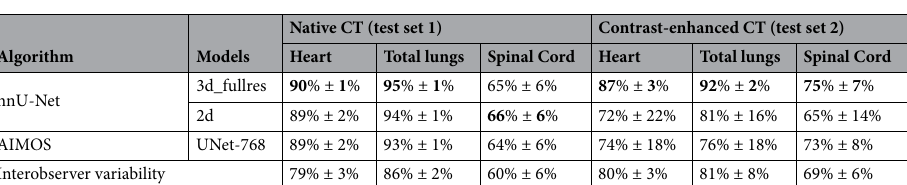
Figure 4. Examples of the best (first row), intermediate (second row), and worst (third row) segmentation results for the ( a ) native CT and ( b ) contrast-enhanced CT datasets obtained by the nnU-Net 3d_fullres model compared to the ground truth. The DSC scores (first value) and 95p HD in mm (second value) for each organ are also given. H, SC, RL and LL correspond to the heart (red), spinal cord (green), right lung (blue) and left lung (yellow), respectively.